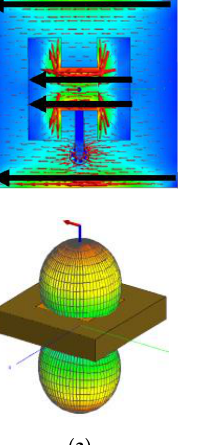
Figure 14. Scattering characteristic currents distribution and far−field patterns comparison for at 7.0 GHz. ( a ) Mode 2 of antenna A; ( b ) mode 2 of antenna B. For the x -polarized incident wave, the scattering characteristic mode analysis of antenna A and antenna B is performed from 4.0 GHz to 8.0 GHz. Figures 15 and 16 show